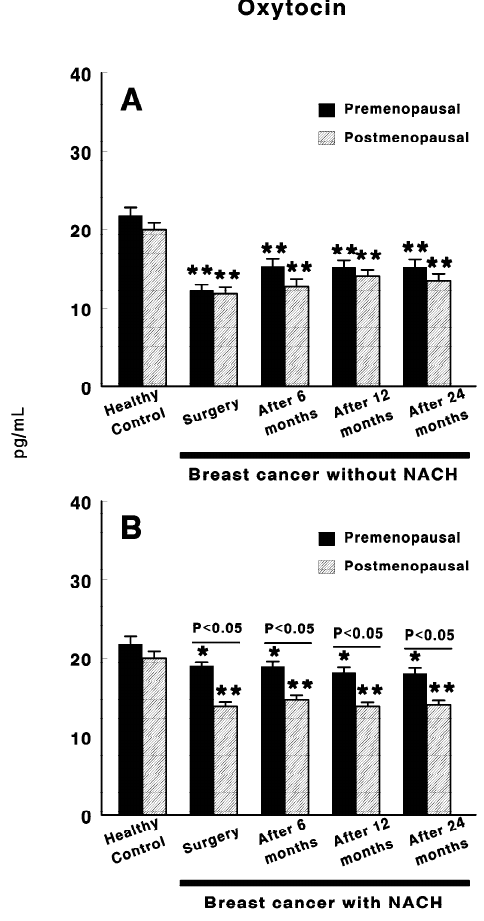
Figure 2. Circulating oxytocin levels in control, preMP and postMP women and in women diagnosed with ductal infiltrating BC who were untreated ( A ) or treated ( B ) with NACH, at the time of the surgery and at 6, 12 and 24 months after surgery. Asterisks represent significant di ff erences between breast cancer patients and healthy control women. The upper lines between bars represent the significant di ff erences between premenopausal and postmenopausal women. Results are expressed in pg / mL (Mean ± SEM; * p < 0.05; ** p < 0.01).